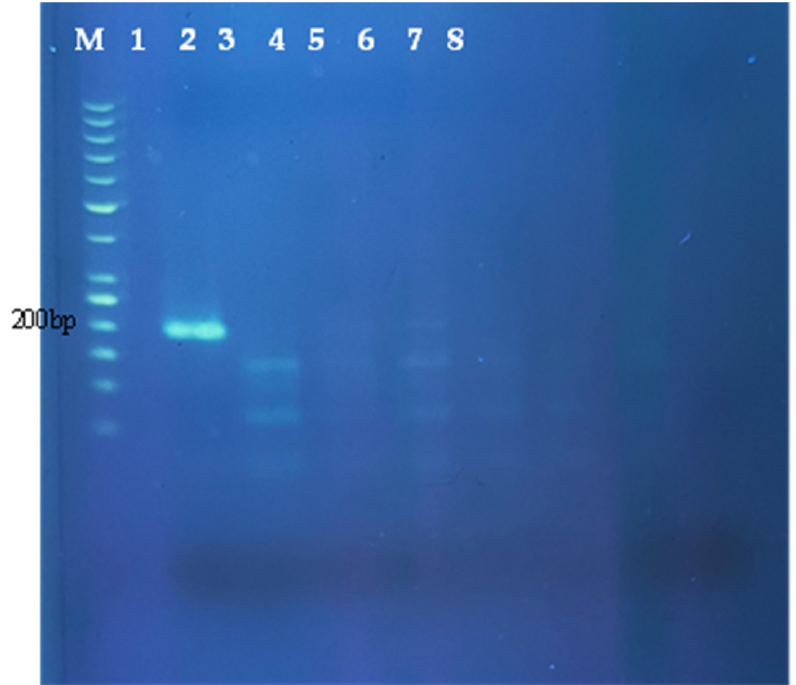
Figure 1. Electrophoresis profile of porcine-specific non-labelled primer RPA products amplified for pork. M—50 bp DNA ladder; 1—pork; 2—beef; 3—mutton; 4—dog; 5—chicken; 6—duck; 7—rabbit; 8—no template control